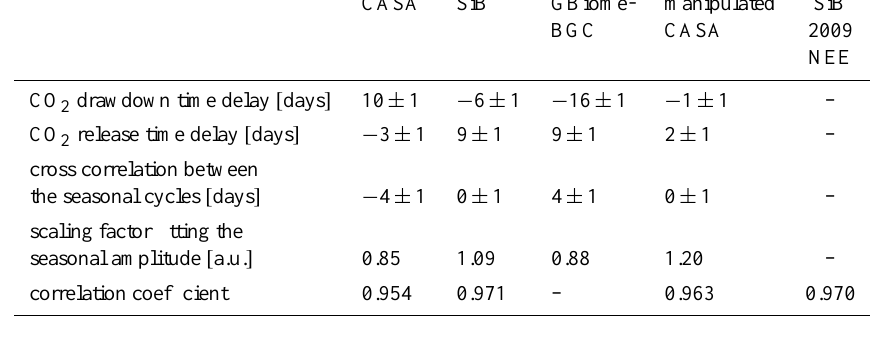
Table 3. Analysis of the GEOS-Chem CO 2 simulations using different NEE estimations. Correlation coefficients for GEOS-Chem CO 2 simulations with TCCON measurements for the CASA inventory (standard/manipulated), year-specific SiB fluxes and SiB climatology.